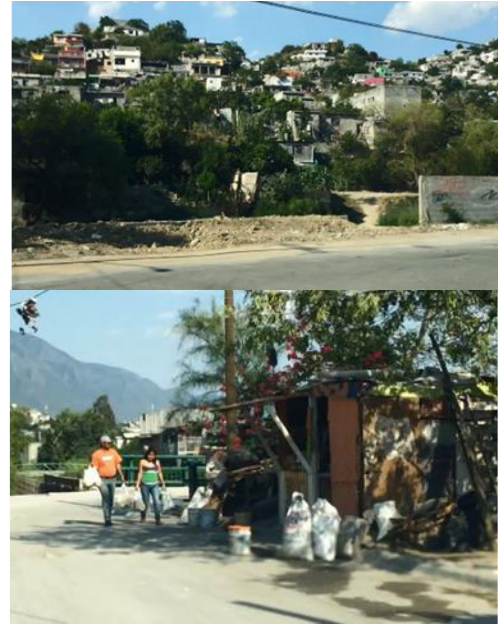
Figure 3 & 4. Informal settlements in Monterrey, Mexico (Gómez,